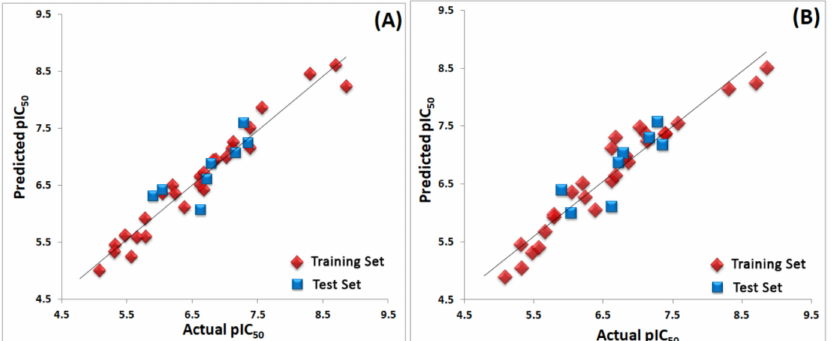
Figure 6. ( A ) Scatter plot for the selected CoMFA model; ( B ) scatter plot for the selected CoMSIA model. The plots shows the actual pIC 50 versus predicted pIC 50 activity of the dataset for training and test sets—the training set compounds are represented as diamonds in red color and the test set compounds are represented as squares in blue color. The correlation coefficient ( r 2 ) for CoMFA was 0.955 and for CoMSIA electrostatic, hydrophobic, and hydrogen bond acceptors (EHAs) it was 0.864.